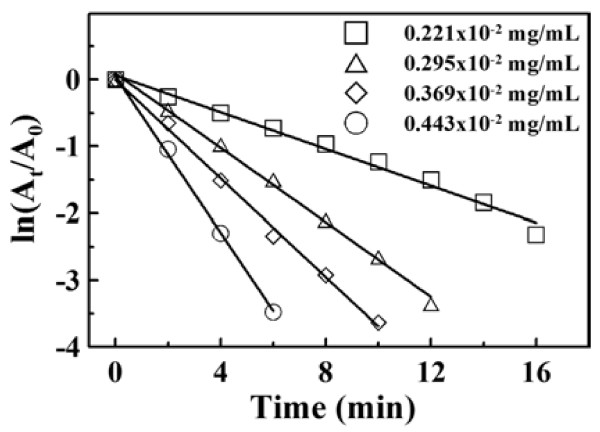
Plots of ln(At/A0) versus time for NaBH4-reduction of 4-NP at different GAAu-MNP amounts. [4-NP] = 1.5 × 10−4 M, [NaBH4] = 1.5 × 10−2 M, 30°C.